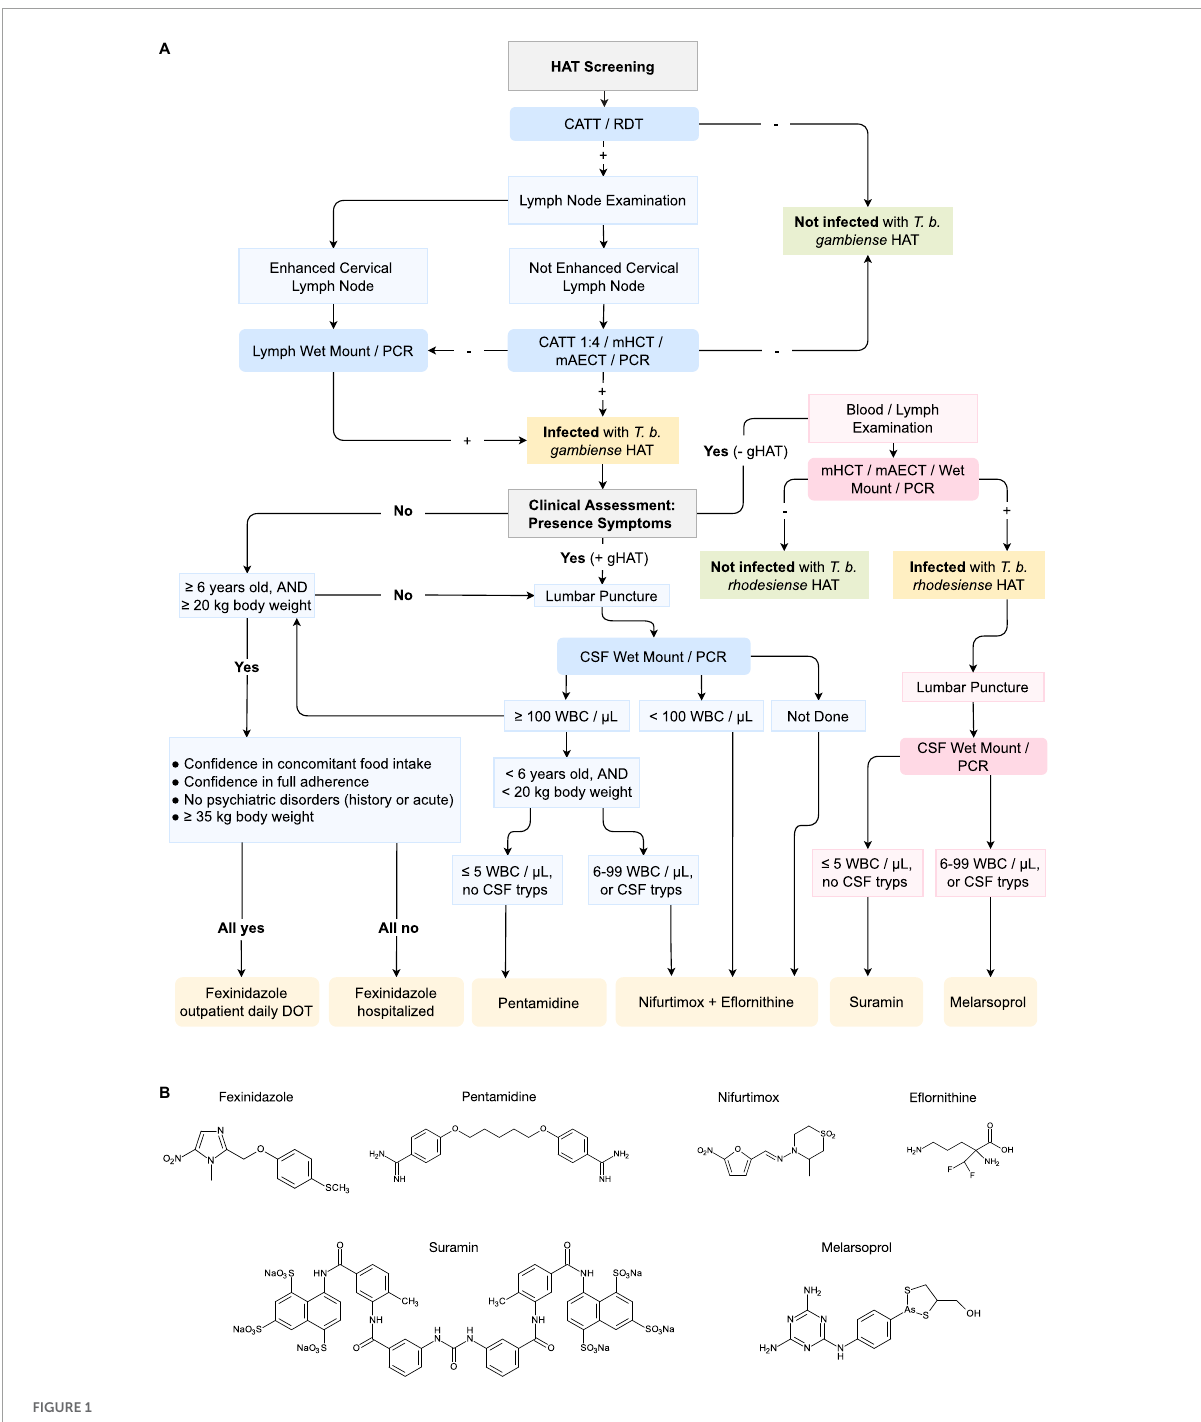
FIGURE1 Pipeline for the diagnosis and treatment of T. b. gambiense and T. b. rhodesiense Human African Trypanosomiasis (HAT) infections. (A) The pipeline includes the diagnosis of HAT through CATT (Card Agglutination Test), RDT (Rapid Diagnosis Test), mHCT (microhaematocrit centrifugation), mAECT (mini-anion exchange centrifugation), PCR (Polymerase Chain Reaction) or other amplification techniques, and CSF (Cerebrospinal Fluid) Wet Mount. DOT (Directly Observed Treatment); WBC (White Blood Cell). In blue, pipeline for the diagnosis of Trypanosoma brucei gambiense HAT, and in pink for T. b. rhodesiense HAT. Recommended drugs for treatment are displayed in orange. Sequence adapted from Geneva: World Health Organization, WHO interim guidelines for the treatment of gambiense Human African Trypanosomiasis, 2019 (101); and Tiberti N., Hainard A. and Sanchez J. C., Translation of Human African Trypanosomiasis biomarkers toward field application, 2013 (105). (B) Chemical formulation of the principal drugs used for the treatment of HAT (molecular structure artwork was kindly provide by Prof. Dr. ir. Philippe Heynderickx of the Ghent University Global